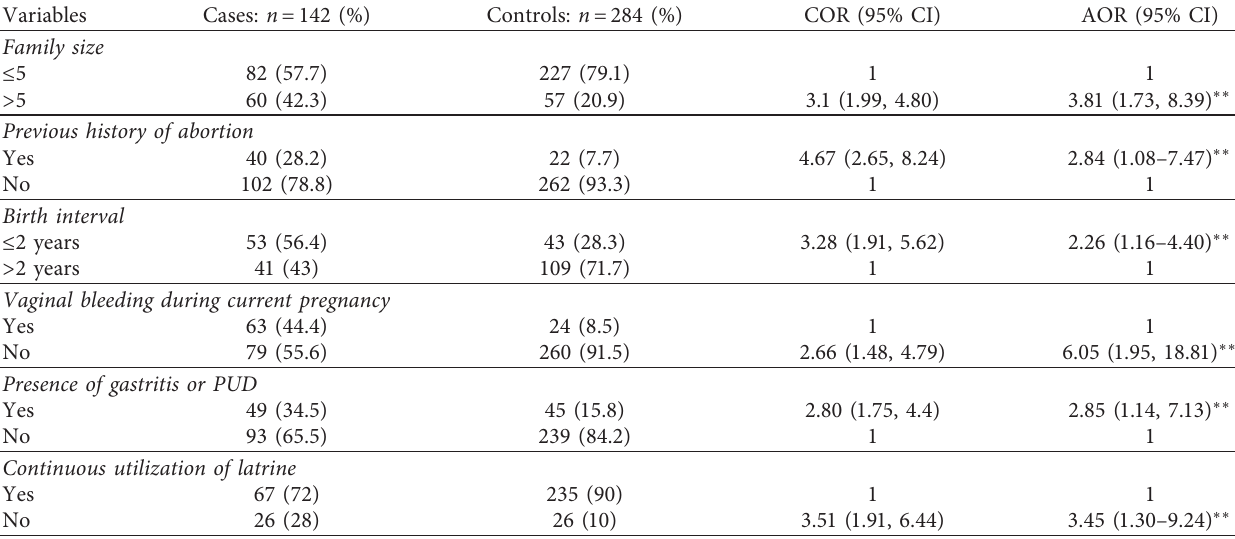
Table 4: Determinants of anemia among pregnant women attending antenatal care follow-up in public hospitals of the West Shewa zone, from February to April 2019 (multivariable